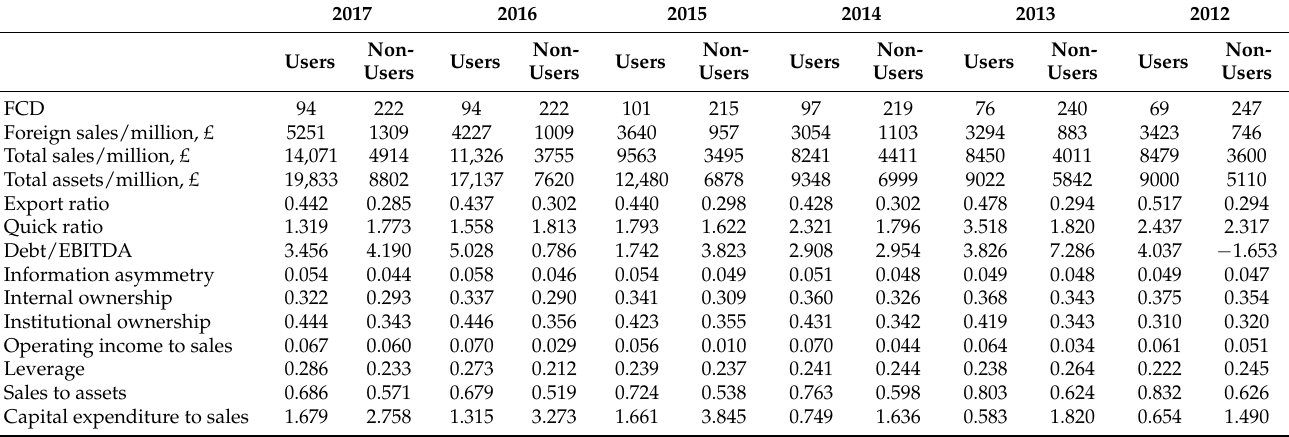
Table 1. Descriptive Statistics.